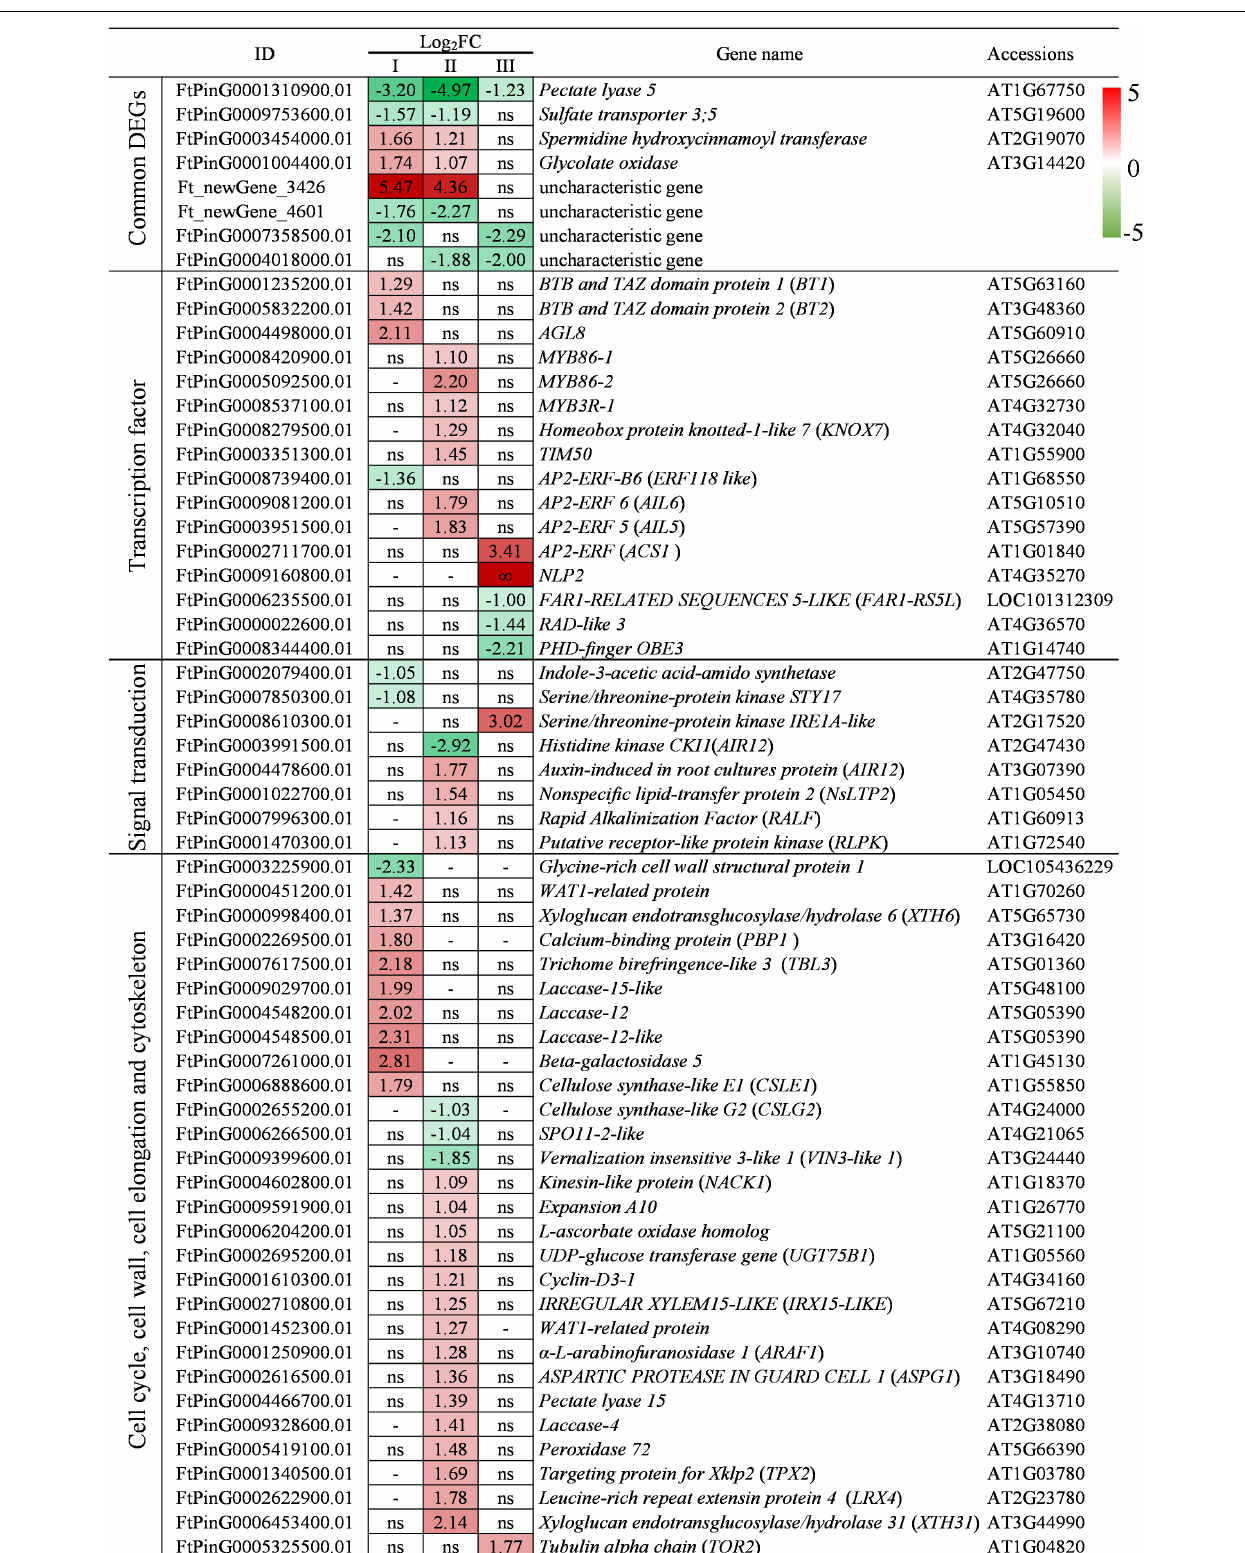
FIGURE 7 | Analysis of DEGs at stage I (before bending), II (bending), and III (after bending). “ns” indicates no significant difference of gene expression was detected between WT and lazy1. “-” indicates the gene expression level was not detected.